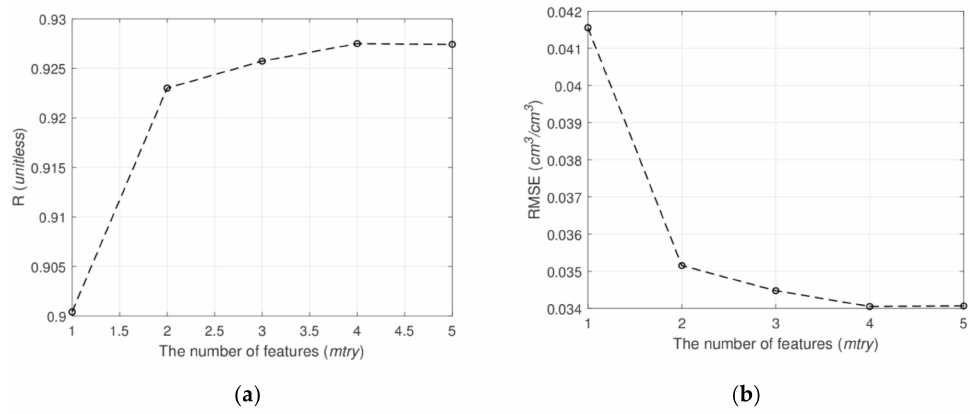
Figure 7. Effects of mtry parameter on the SM retrieval performance. ( a ) R and ( b )